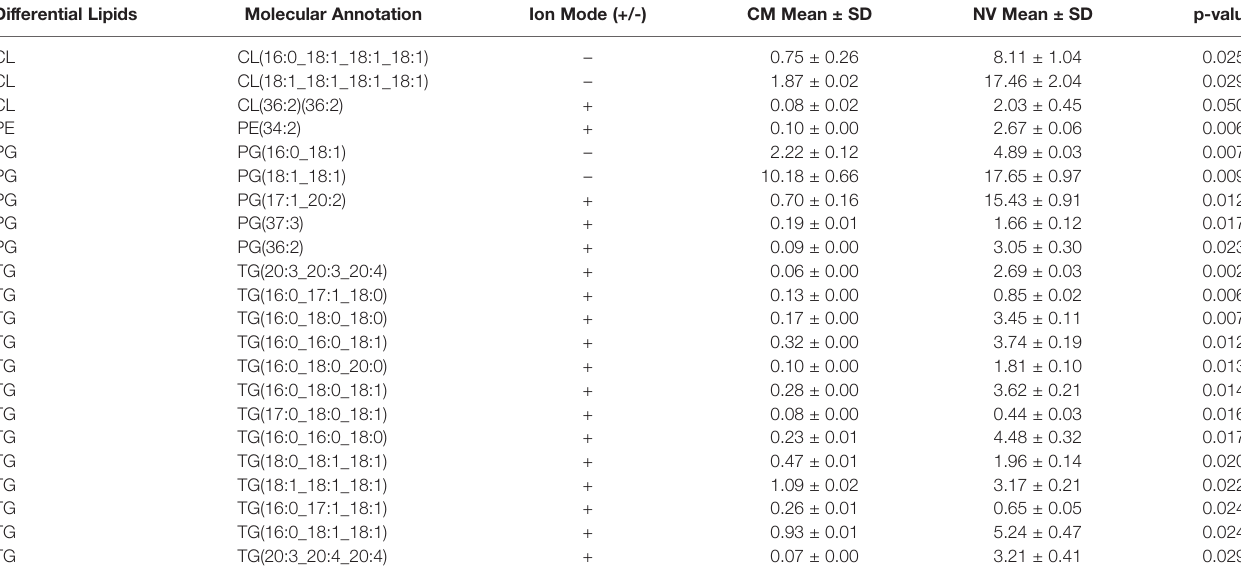
TABLE 2 | Lipids enriched in the NV of L. johnsonii N6.2. The Mean and standard deviation (± SD) was calculated from the relative abundance obtained from each biological triplicate. Differential Lipids Molecular